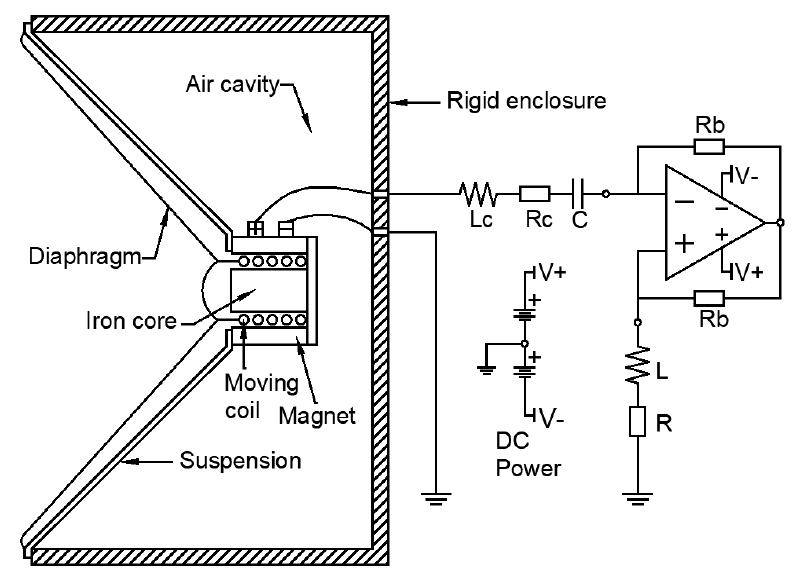
Figure 1. Schematic of the shunted loudspeaker with an NIC. Table 1. Technical data for the loudspeaker Hivi – M4N. Table 1. Technical data for the loudspeaker Bl